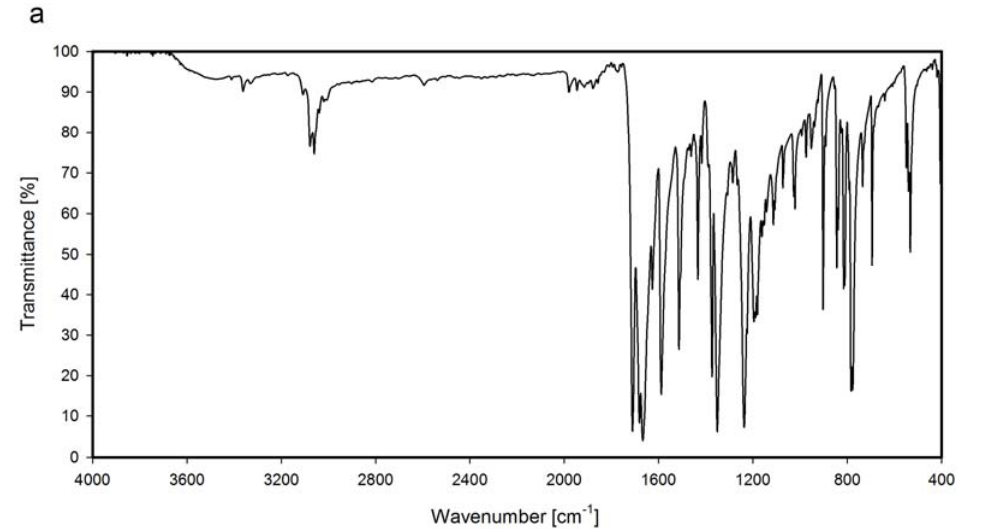
Figure 2. FTIR spectrum of N,N' -(1,4-phenylene)-bis(1,8-naphthalimide) ( NP2 ); ( a ) range 4000–400 cm − 1 ; ( b ) range 2000–400 cm − 1